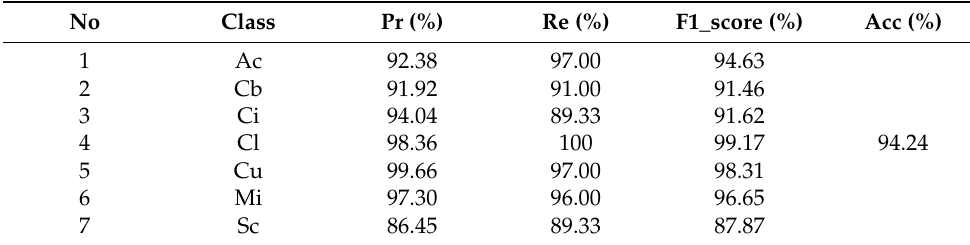
Table 5. The classification results for the ASGC dataset.